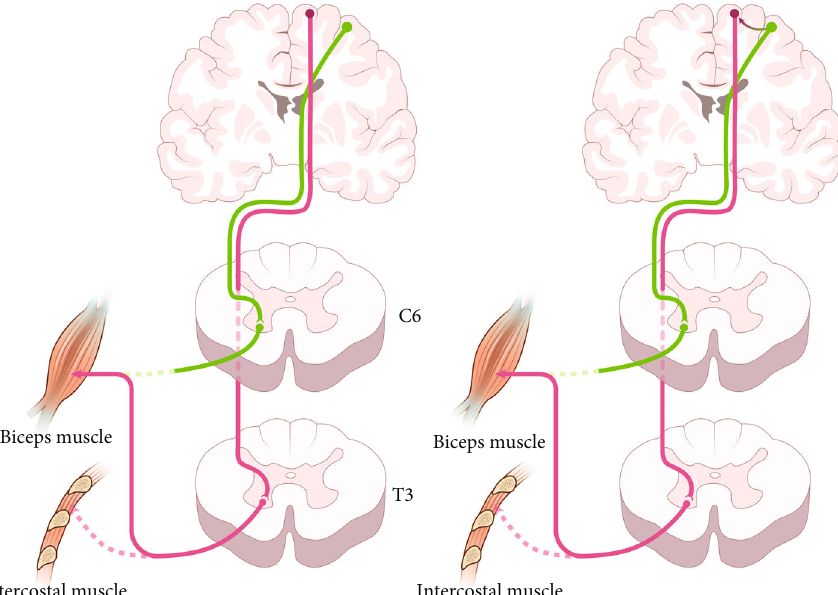
Figure 2: Neuroplasticity after an intercostal-to-musculocutaneous nerve transfer with moderate clinical outcomes. In the early phase of morphological reinnervation (left), biceps contraction is mediated by the original intercostal nerve ’ s primary motor cortex located in the midline. The descending pathway for elbow fl exion from the motor cortex to the motor neuron pool of the intercostal nerve T3 is shown in red. Several years later (right), patients begin to contract their biceps independently of respiration. The cortical region representing musculocutaneous nerve delivers the motor control command to biceps brachii via the new relay diaphragm area. The new connection between the 2 cortexes (curved arrow) is